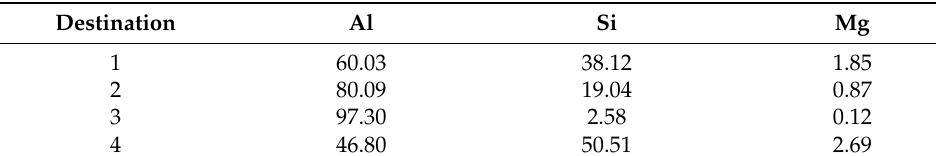
Table 4. The EDS analysis of A3 sample in Figure 12 (wt.%).